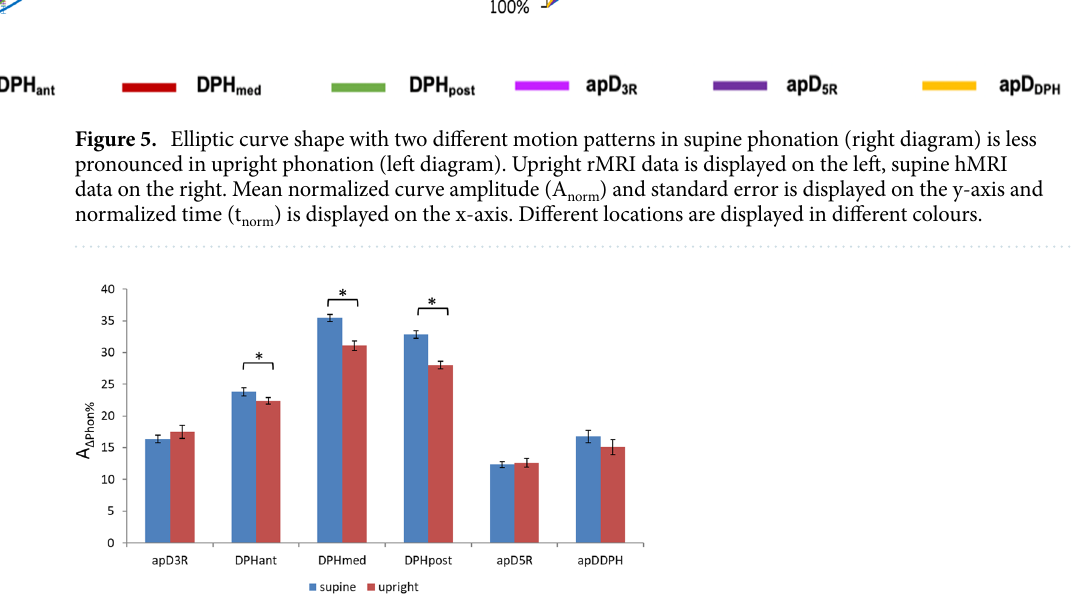
Figure 6. Larger cranial diaphragm displacement during supine compared to upright phonation. Y-axis shows the percentual movement range (A ∆Phon% ) during phonation. Bars represent different locations in upright (red) and supine (blue) position including standard error. Significant differences are marked with *. All p-values are displayed in Supplementary Table S9